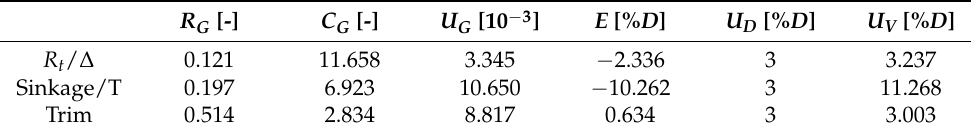
Table 3. Validation factors of the uncertainty